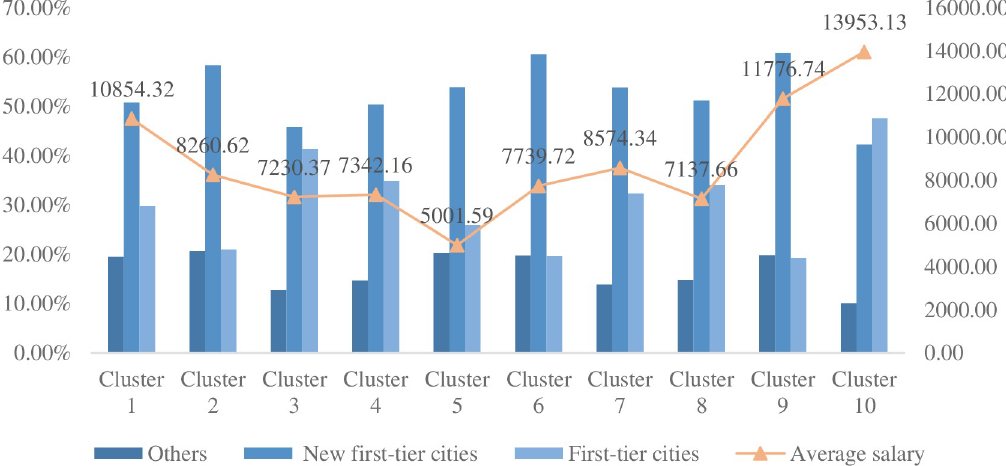
Fig 6. The proportion of urban demand and the average salary for each job category. The share of the demand for each job category in each city and the average salary of each job category are calculated based on the RMB income.